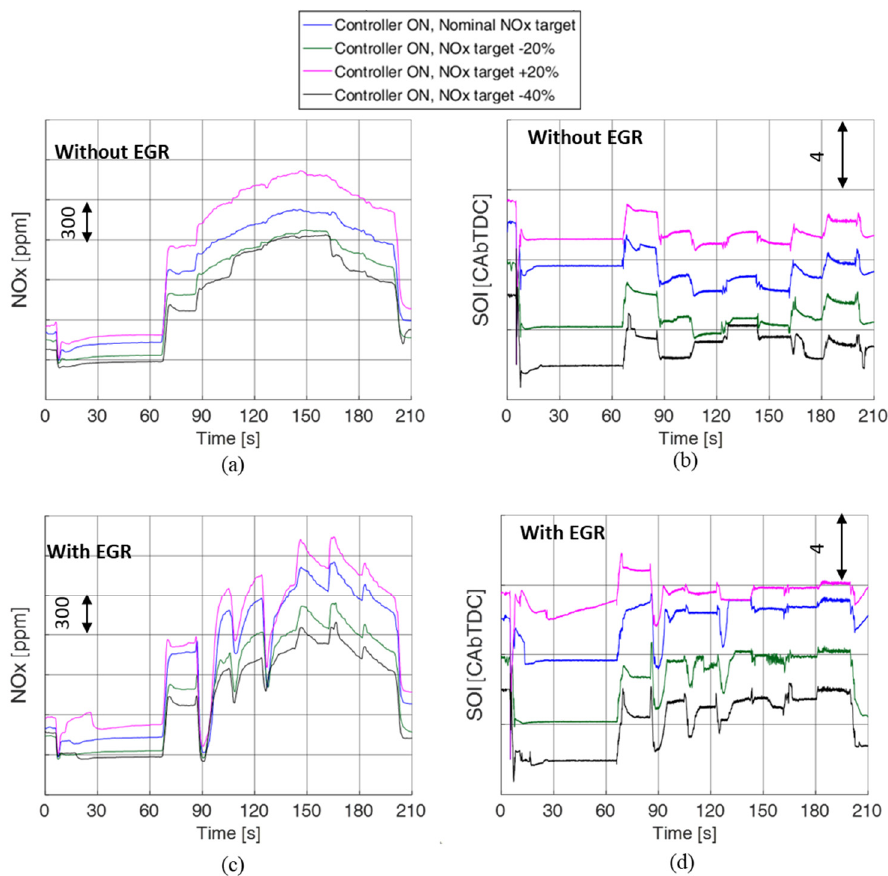
Figure 9. Main results obtained in the IMPERIUM project [10]: comparison of the time histories of the measured NOx emissions ( a , c ) and of SOI main ( b , d ) for ramp test 2 without EGR ( a , b ) and with EGR ( c , d ). The origin of the y-axis is the same in all the figures.